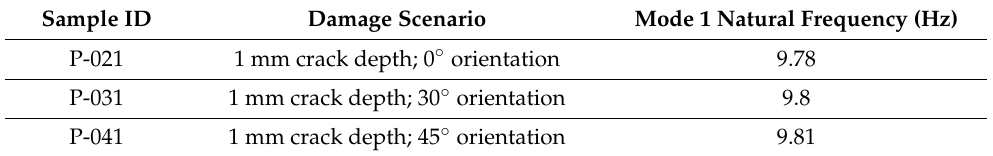
Figure 6. MSE-DI implementation (bottom layer) to hybrid-stiffened sample: 45 ◦ cracked sample. Table 3. The first mode natural frequency of MSE-DI simplified ABS skin